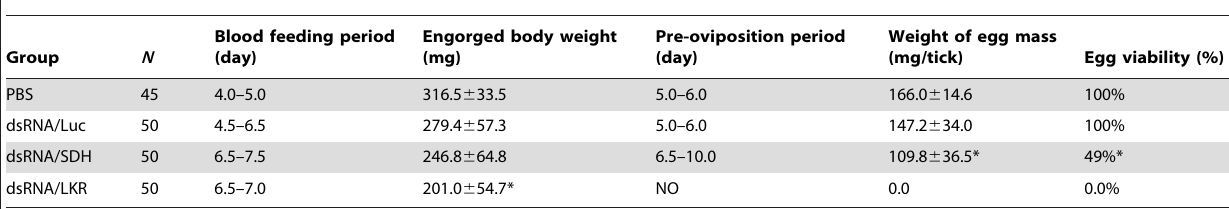
Table 1. Effect of dsRNA treatment on tick oviposition.